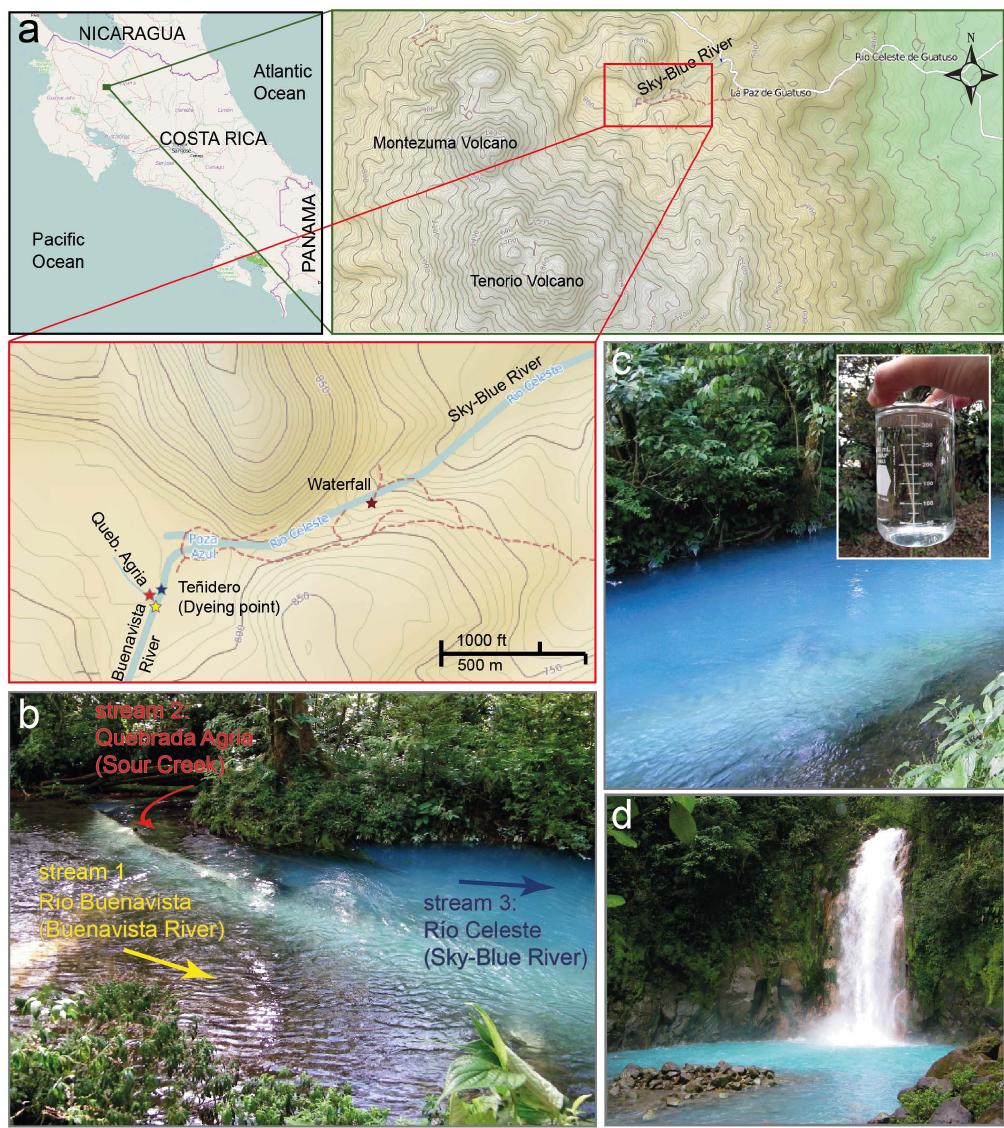
Figure 1. Location of Rı´o Celeste and the dye point. ( a ) Rı´o Celeste is located in Costa Rica within the Tenorio Volcano National Park (Alajuela, Guatuso, 10 u 42 9 02.5 0 N, 84 u 59 9 49.3 0 W). Maps taken from OpenStreetMaps (http://www.openstreetmap.org/). ( b ) As seen in the picture, the sky-blue color of Rı´o Celeste originates from the mixing of two transparent streams (Rı´o Buenavista and Quebrada Agria) at a point known as ‘‘Ten˜idero’’ (dye point). That characteristic makes a remarkable difference from other blue waters of thermal origin. ( c ) The intense sky-blue color appears immediately after the dye point. The sky-blue color is maintained just in the river: a water sample (see box in figure) outside the stream is completely colorless. ( d ) The river maintains its peculiar coloration over a distance more than 14 km including at the waterfall Rı´o Celeste.